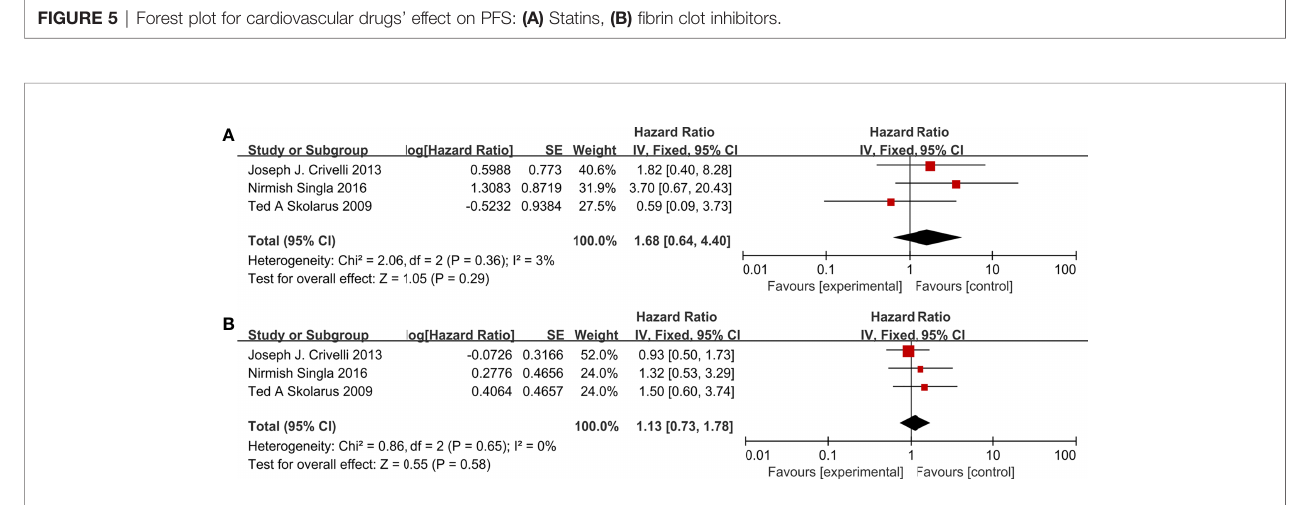
FIGURE 5 | Forest plot for cardiovascular drugs ’ effect on PFS: (A) Statins, (B) fi brin clot inhibitors.